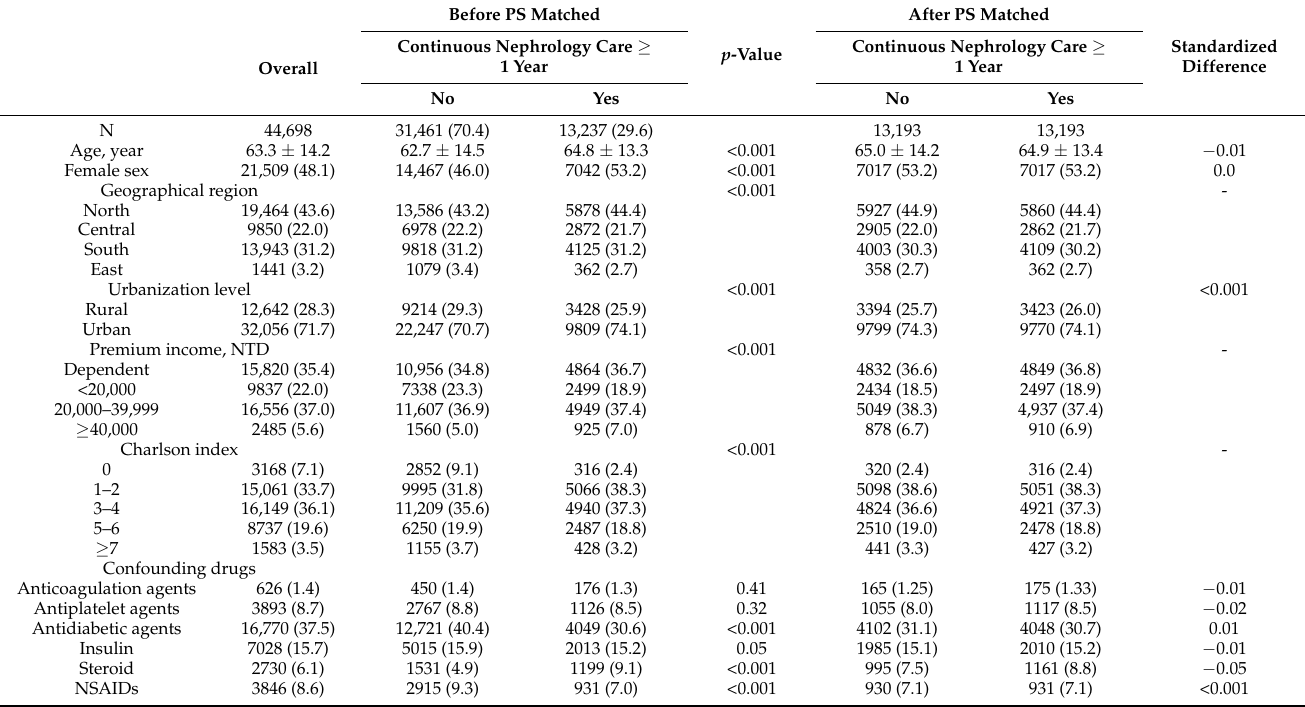
Table 1. Patient characteristics.